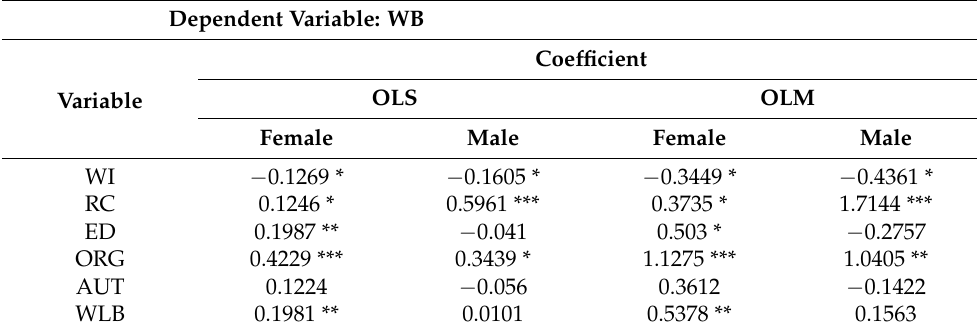
Table 5. Results of the regression—model